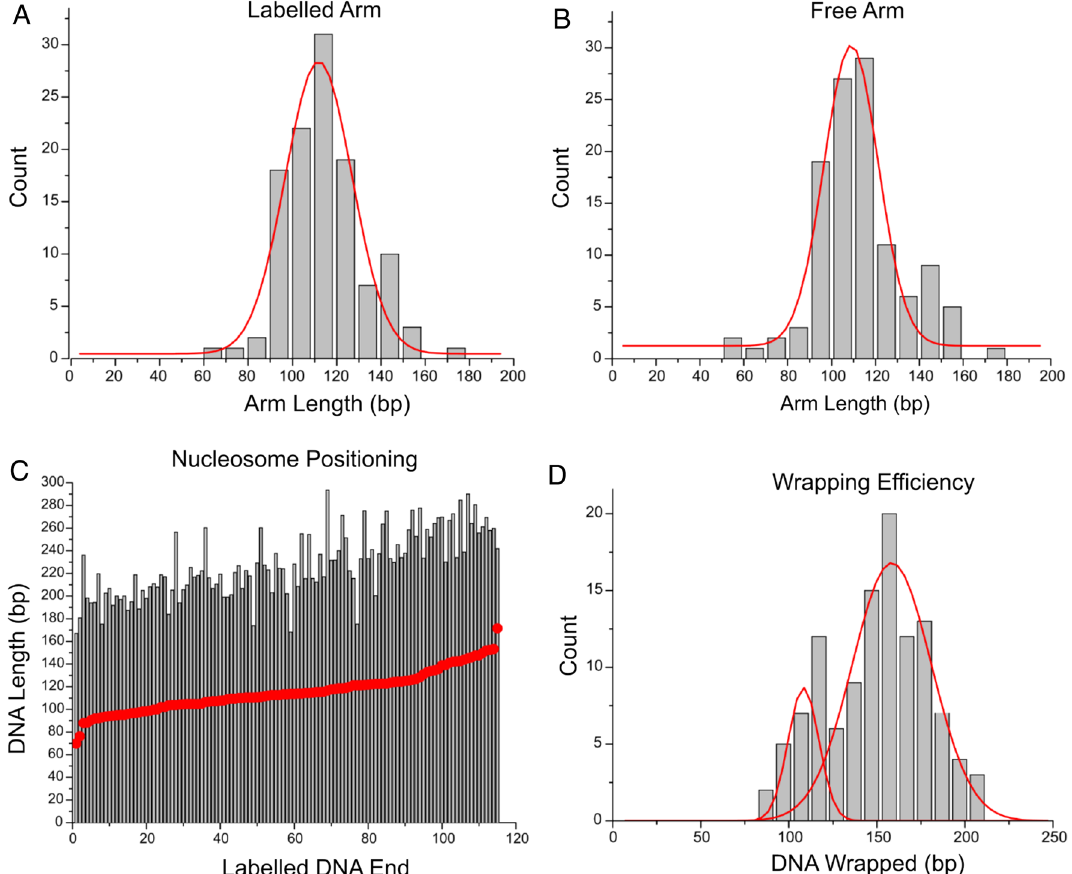
Figure 2. Analysis of modified mononucleosomes with the H4 histone tail truncated assembled on the 601 positioning substrate. Histograms ( A , B ) reveal labelled and free arm lengths of 116 ± 2 bp (SEM) and 113 ± 2 bp (SEM), respectively. ( C ) Positional mapping of modified nucleosomes on the positioning substrate demonstrates positioning according to the location of the 601 motif. ( D ) Histogram of nucleosome wrapping efficiency. The mean value of wrapping efficiency is 147 ± 3 bp (SEM). Under and over wrapped populations are fitted by Gaussian The nucleosome positions were mapped in the same manner as they were on the 601 substrate and the results can be seen in Fig. 3C. Nucleosome positions indicated by the blue circles are organized from shortest to furthest distance from the streptavidin-bound end and reveal no positional preference along the substrate, other than a small population positioned at the free DNA end. The wrapping efficiency data for these nucleosomes shown in Fig. 3D demonstrate a consistently under wrapped state, however, with a mean value of wrapped DNA at 133 ± 4 bp (SEM). AFM analysis of dinucleosomes with two positioning sequences. To further explore the role of the H4 tail in chromatin structure and accessibility, we studied its role in the assembly of dinucleosomes. We first assembled dinucleosomes on a template containing two copies of the Widom 601 sequence with a 60 bp linker between them (Fig. S1C). Studies of dinucleosomes with two positioning sequences were performed by assem- bling both canonical nucleosomes and H4 truncated nucleosomes for comparison using the DNA template containing two copies of the Widom 601 sequence. Representative images of assembled dinucleosomes can be seen in Fig. 4, with canonical nucleosomes shown in (A) and H4 truncated nucleosomes shown in (B). Selected complexes are shown below large images. The zoomed snapshots that were selected ((i–iii)) show dinucleosomes assembled with different internucleosomal distances. Gold arrows point to nucleosome core particles and white arrows point to bound rhizavidin. From these images, we obtained characterizing data such as flank lengths, internucleosomal distance, nucleosome position, and mean wrapping efficiency. The free DNA and flank lengths were determined the same way as for mononucleosomes. Internucleosomal distance, or linker length, was measured as the distance from the center of one nucleosome to the center of the other nucleosome and then subtracted by 10 nm to account for the contribution of the nucleosome core diam- eter. Rhizavidin was used as a reference point in place of streptavidin on all dinucleosome constructs, as the smaller size of the protein makes the distinction of the reference point clearer in this more complicated system. From the image analysis, parameters such as arm length, wrapping efficiency, internucleosomal distance, and positioning were determined.